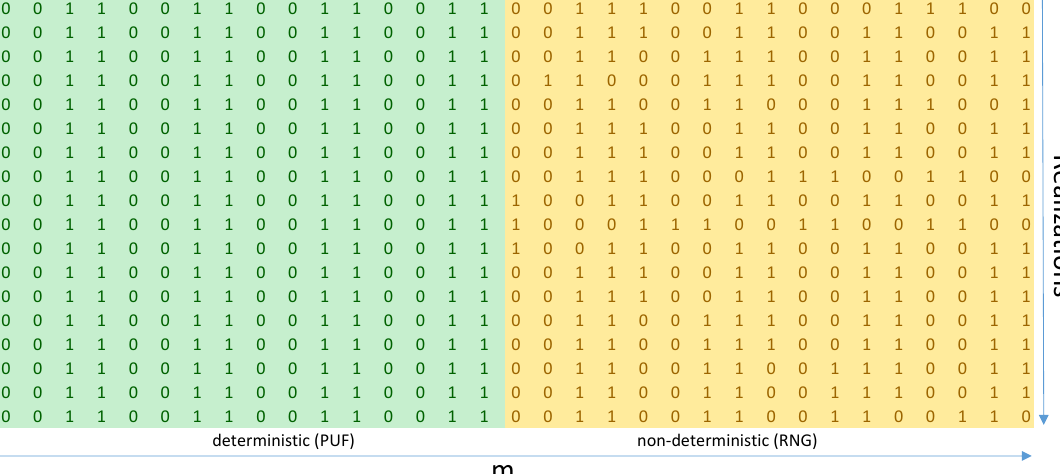
Figure 7. Bit-strings obtained for multiple realization in a single instance.